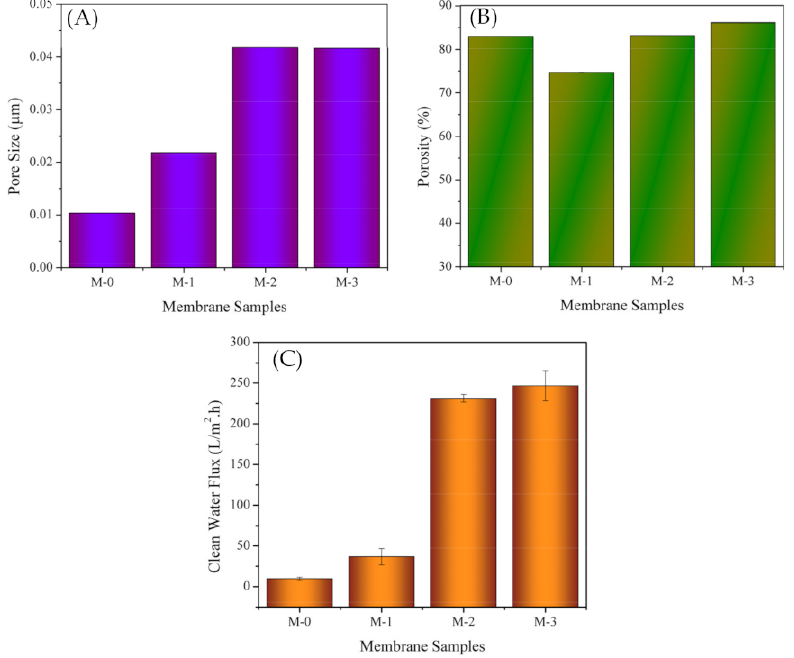
Figure 5. The pore size of the membrane samples estimated using the Guerout–Elford–Ferry equa- tion ( A ), membrane porosity using ImageJ ( B ), and the clean water flux ( C